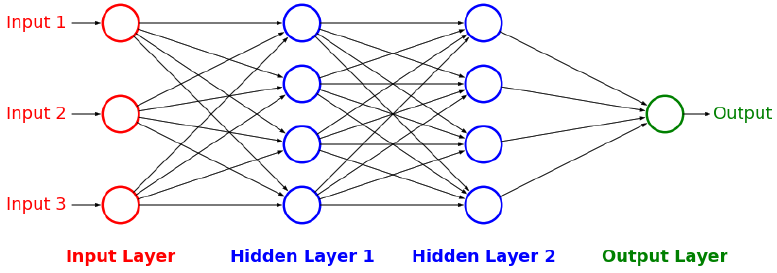
Figure A5. Conventional ANN structure with two hidden layers.